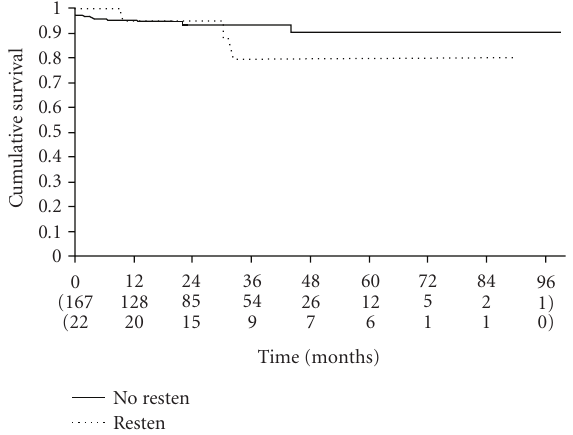
Figure 3: Kaplan Meyer analysis curves of the cumulative freedom from stroke and death in patients with (dotted line) and without (continuous line)